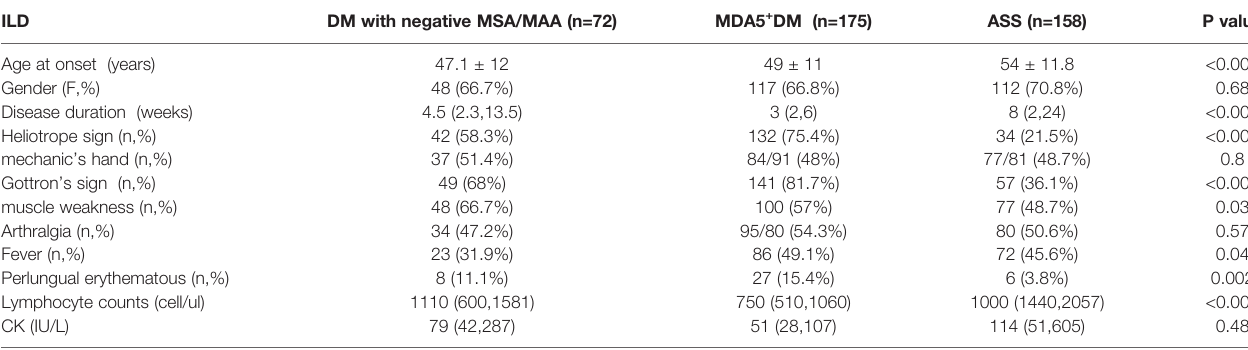
TABLE 1 | The comparison of clinical features among ILD patients with negative MSA/MAA, anti MDA5 and anti-ARS antibodies. ILD DM with negative MSA/MAA (n=72) MDA5 + DM (n=175) Age at onset (years)